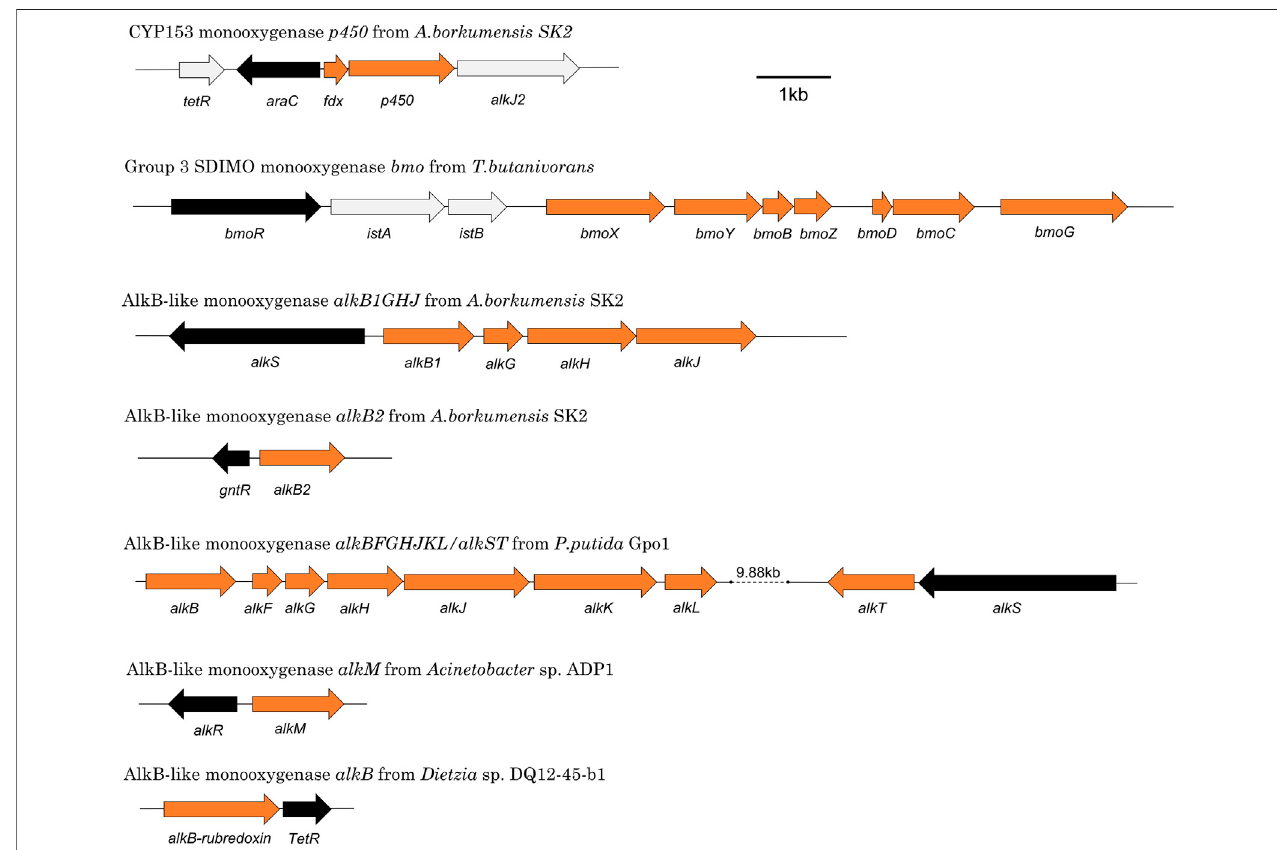
FIGURE 2 | Representative monooxygenase gene clusters showing relative arrangements of metabolic genes (orange) and regulatory genes (black).